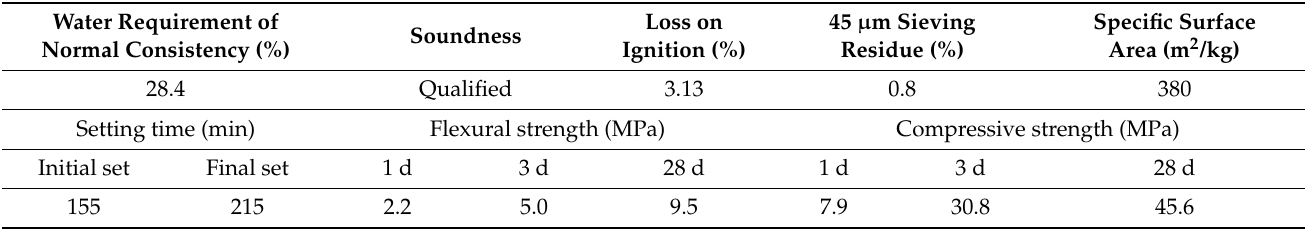
Table 1. Physical and mechanical properties of OPC used for this research.